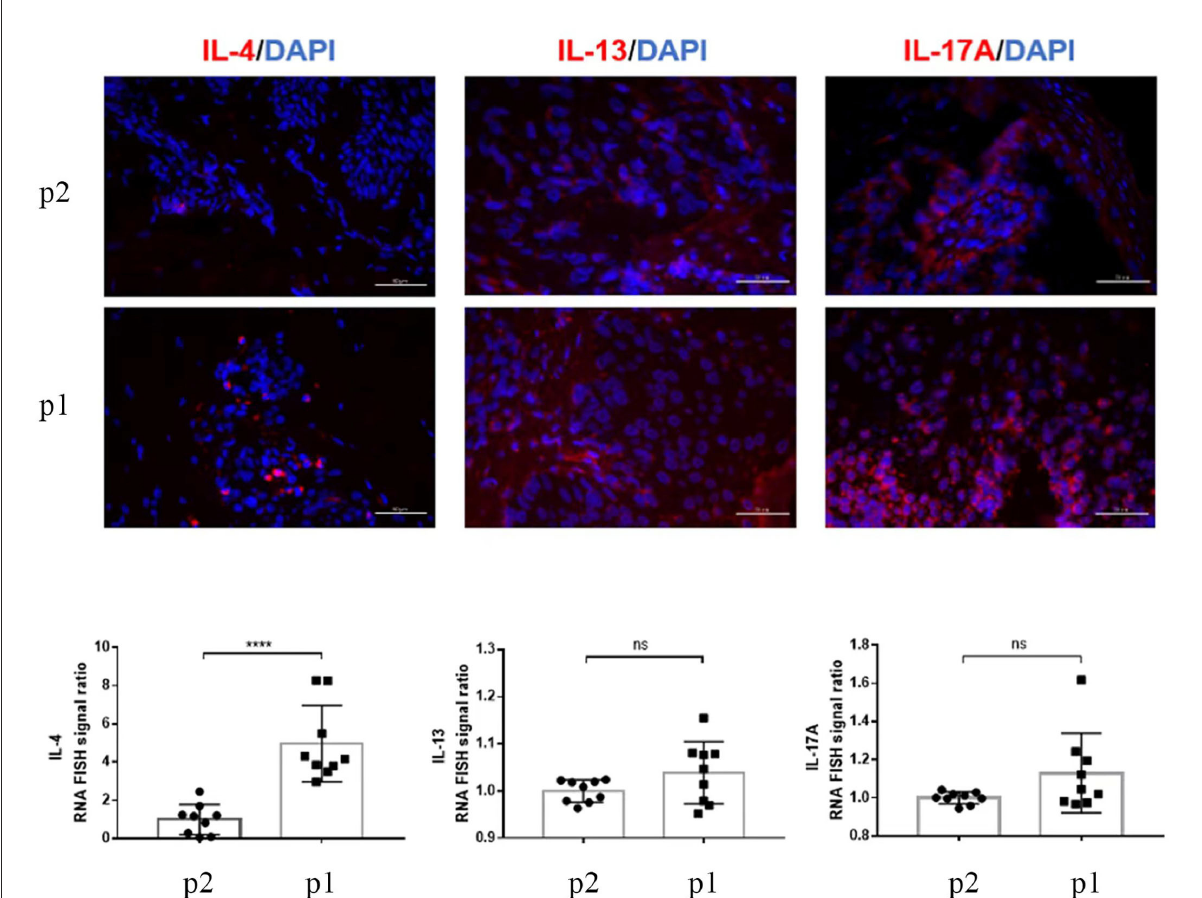
FIGURE4 RNA-FISH images show the expression of IL-4, IL-13, and IL-17A (red) in skin tissue sections P2 (Patient 2) and P1 (Patient 1). More than nine random areas on each slide were examined, and representative images were shown. Scale bars are 50 µ m. The quantification of nine images is shown, and data are presented as mean values ± SD. The positive RNA-FISH signals were analyzed using the ImageJ software. Statistical analyses were conducted using GraphPad Prism 7. * * * * p < 0.0001, ns: p >